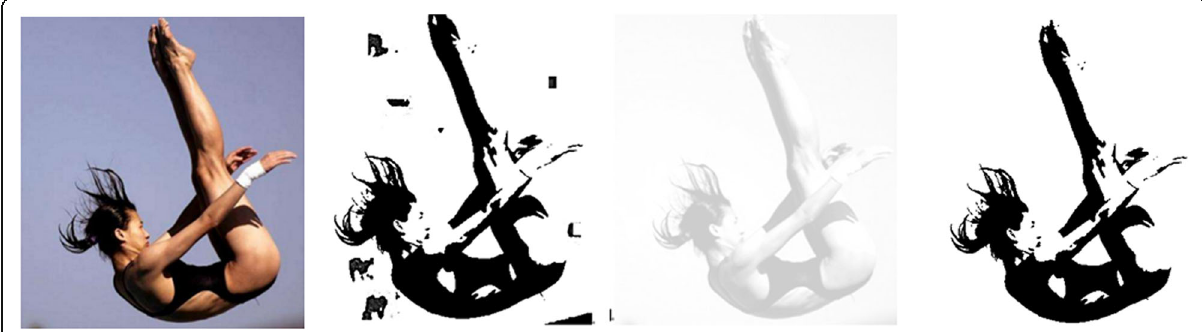
Fig. 6 Estimation results of global motion